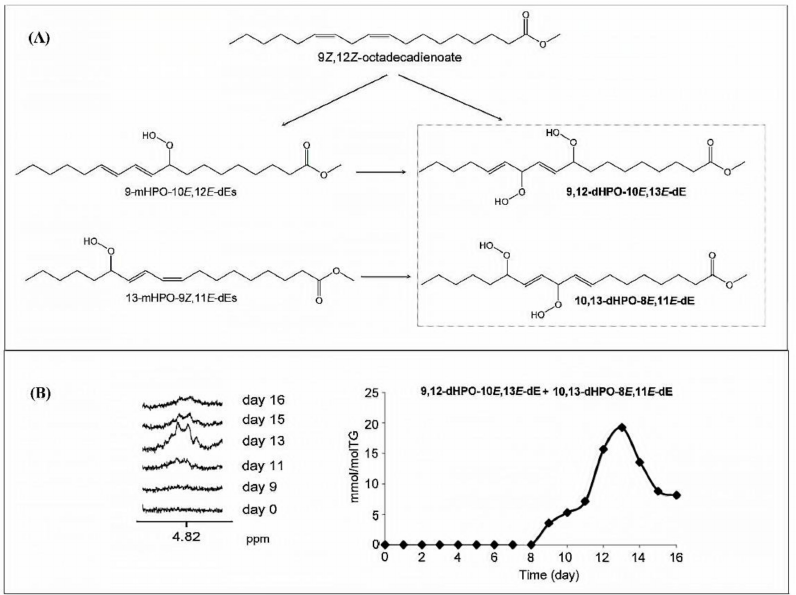
Figure 52. ( A ) Pathways of formation of dihydroperoxy-nonconjugated dienes (dHPO-nc-dEs). ( B ) Selected spectral region where changes occur during the accelerated storage process and their evolution with time, together with the graphical representation of the evolution of the concentration of 9,12-dHPO-10 E ,13 E -dE + 10,13-dHPO-8 E ,11 E -dE, expressed as mmol/mol TG, versus time